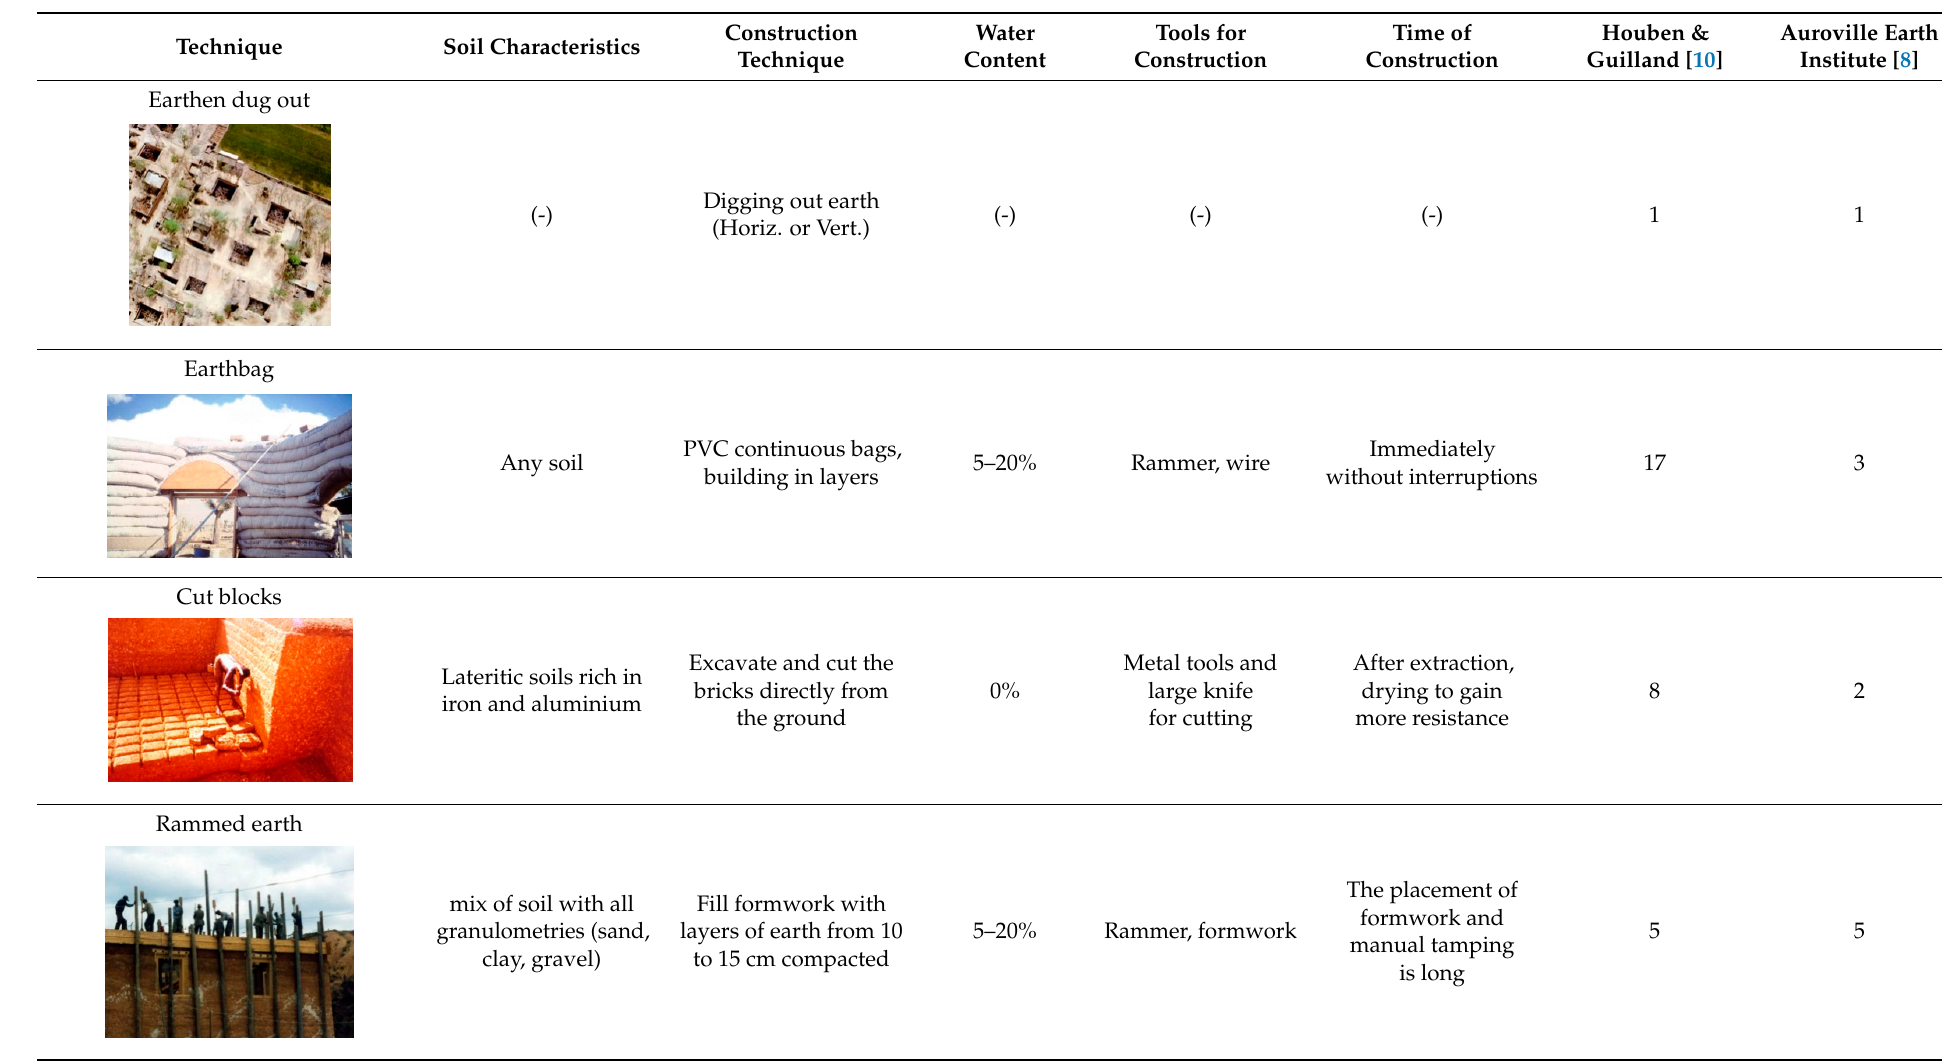
Table 1. Main characteristics for earth construction technologies and correspondence with literature classifications.